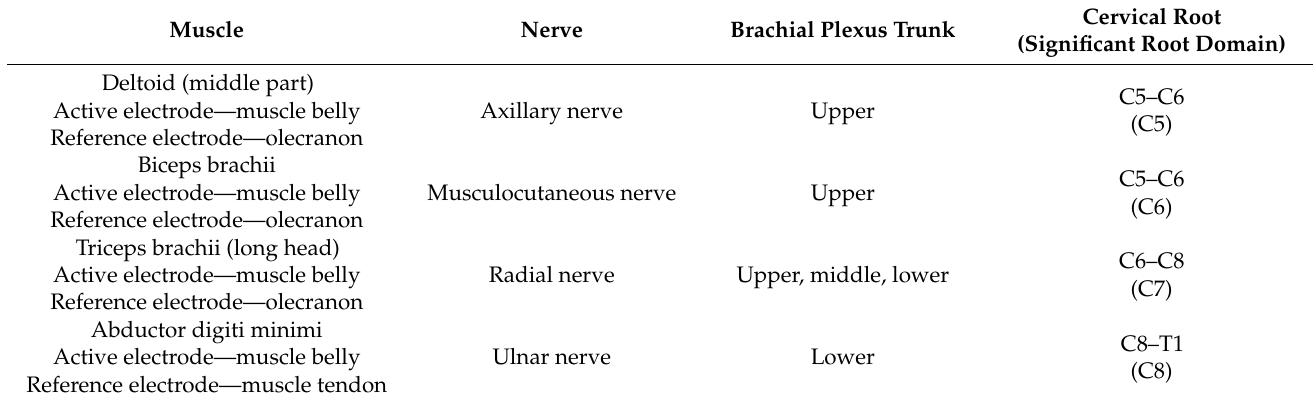
Table 2. Summary of examined muscles, their peripheral innervation, and root domain. Nerve Brachial Plexus